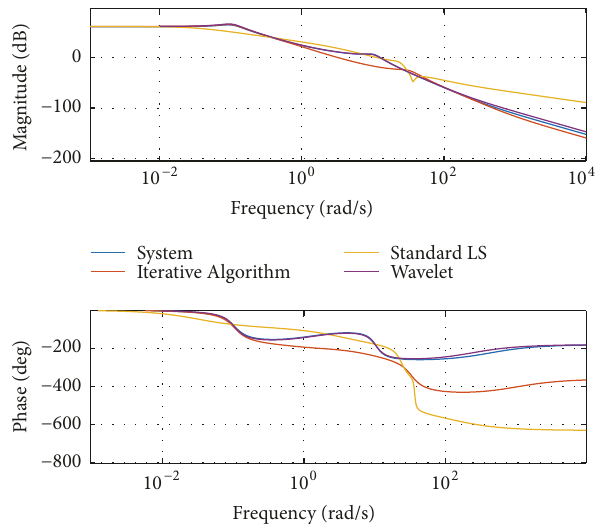
Figure 9: Model identified on full range frequency: Bode plot.